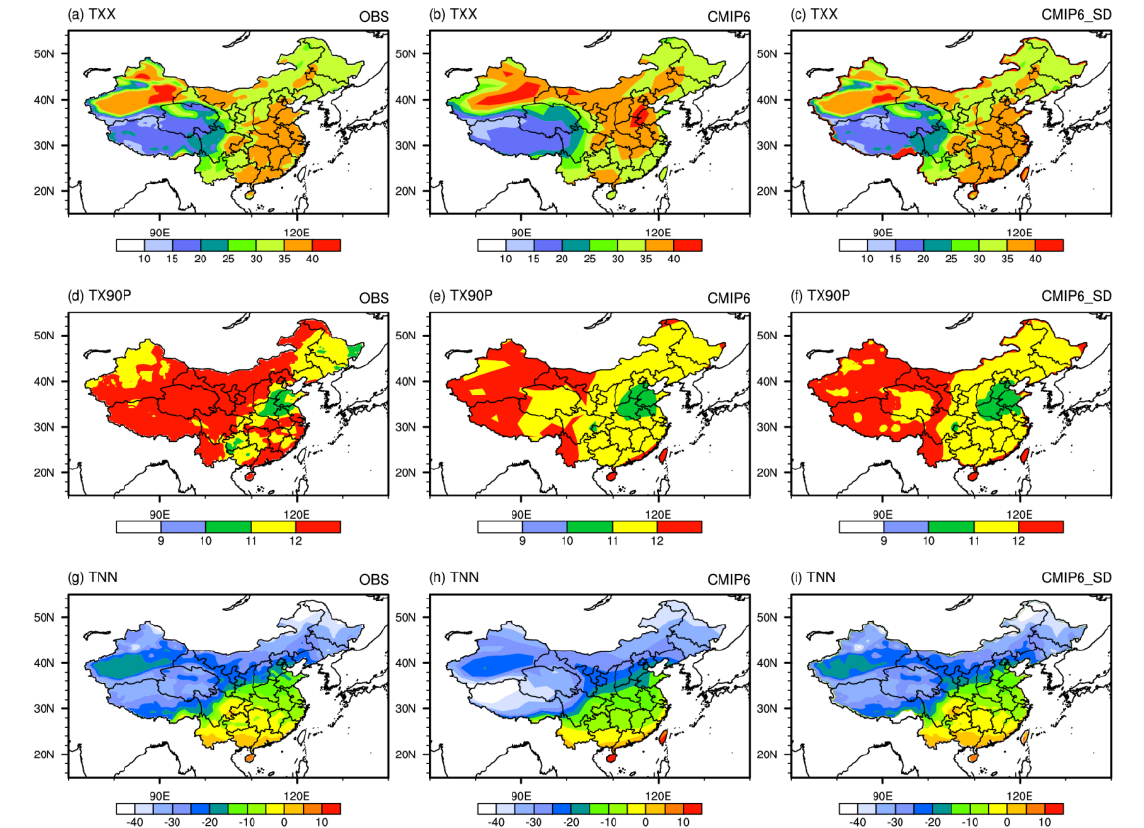
Figure 2. Spatial patterns of extreme temperature indices (TXX and TNN, units: °C; TX90P, units: %) in China (1961–2014) for observation ( left panel), CMIP6 MME ( middle panel), and MME of downscaled dataset ( right panel).